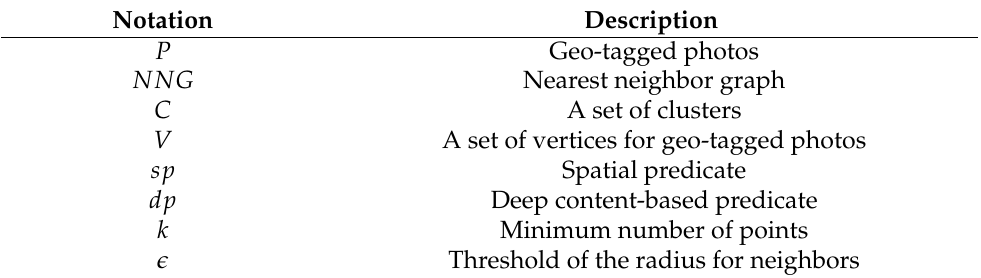
Table 1. Notations and